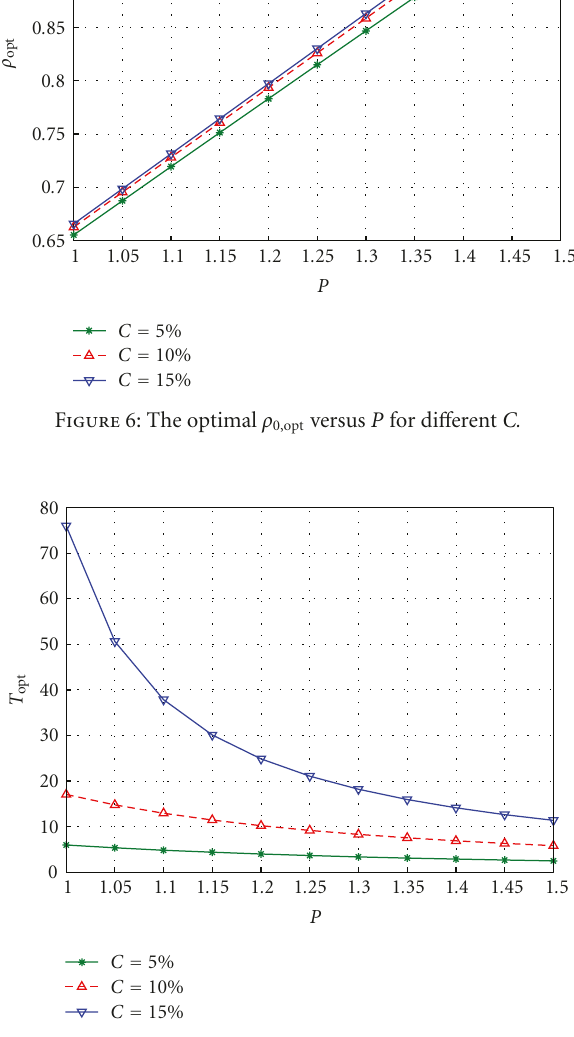
Figure 7: The optimal T opt versus P for di ff erent C.